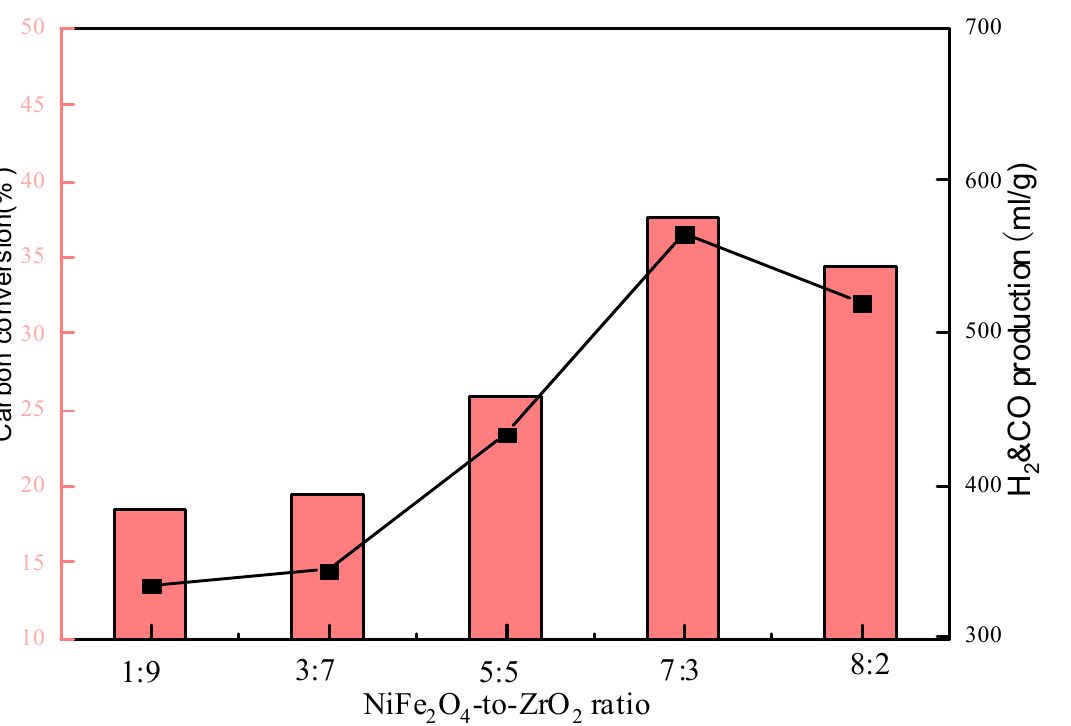
Figure 4. E ff ect of O/B ratio on CLG.